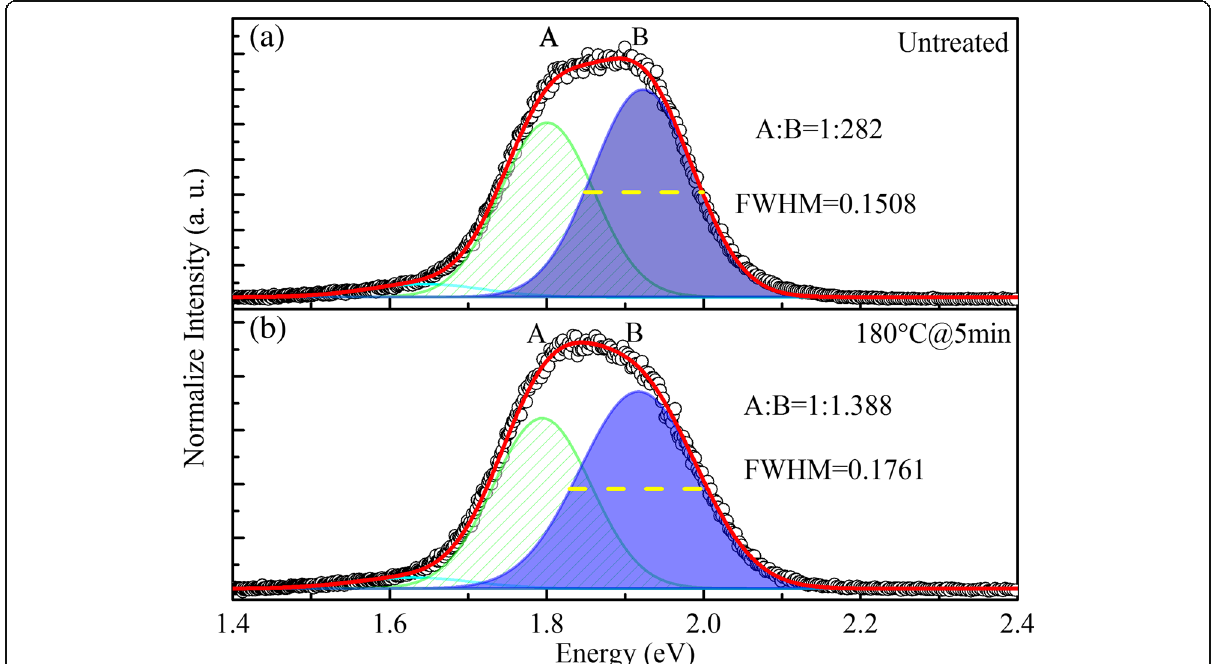
Fig. 5 The fitted curves by three individual Gaussian peaks of two samples ( a for untreated sample and b for sample annealed at 180 °C for 5 min) in 300 K